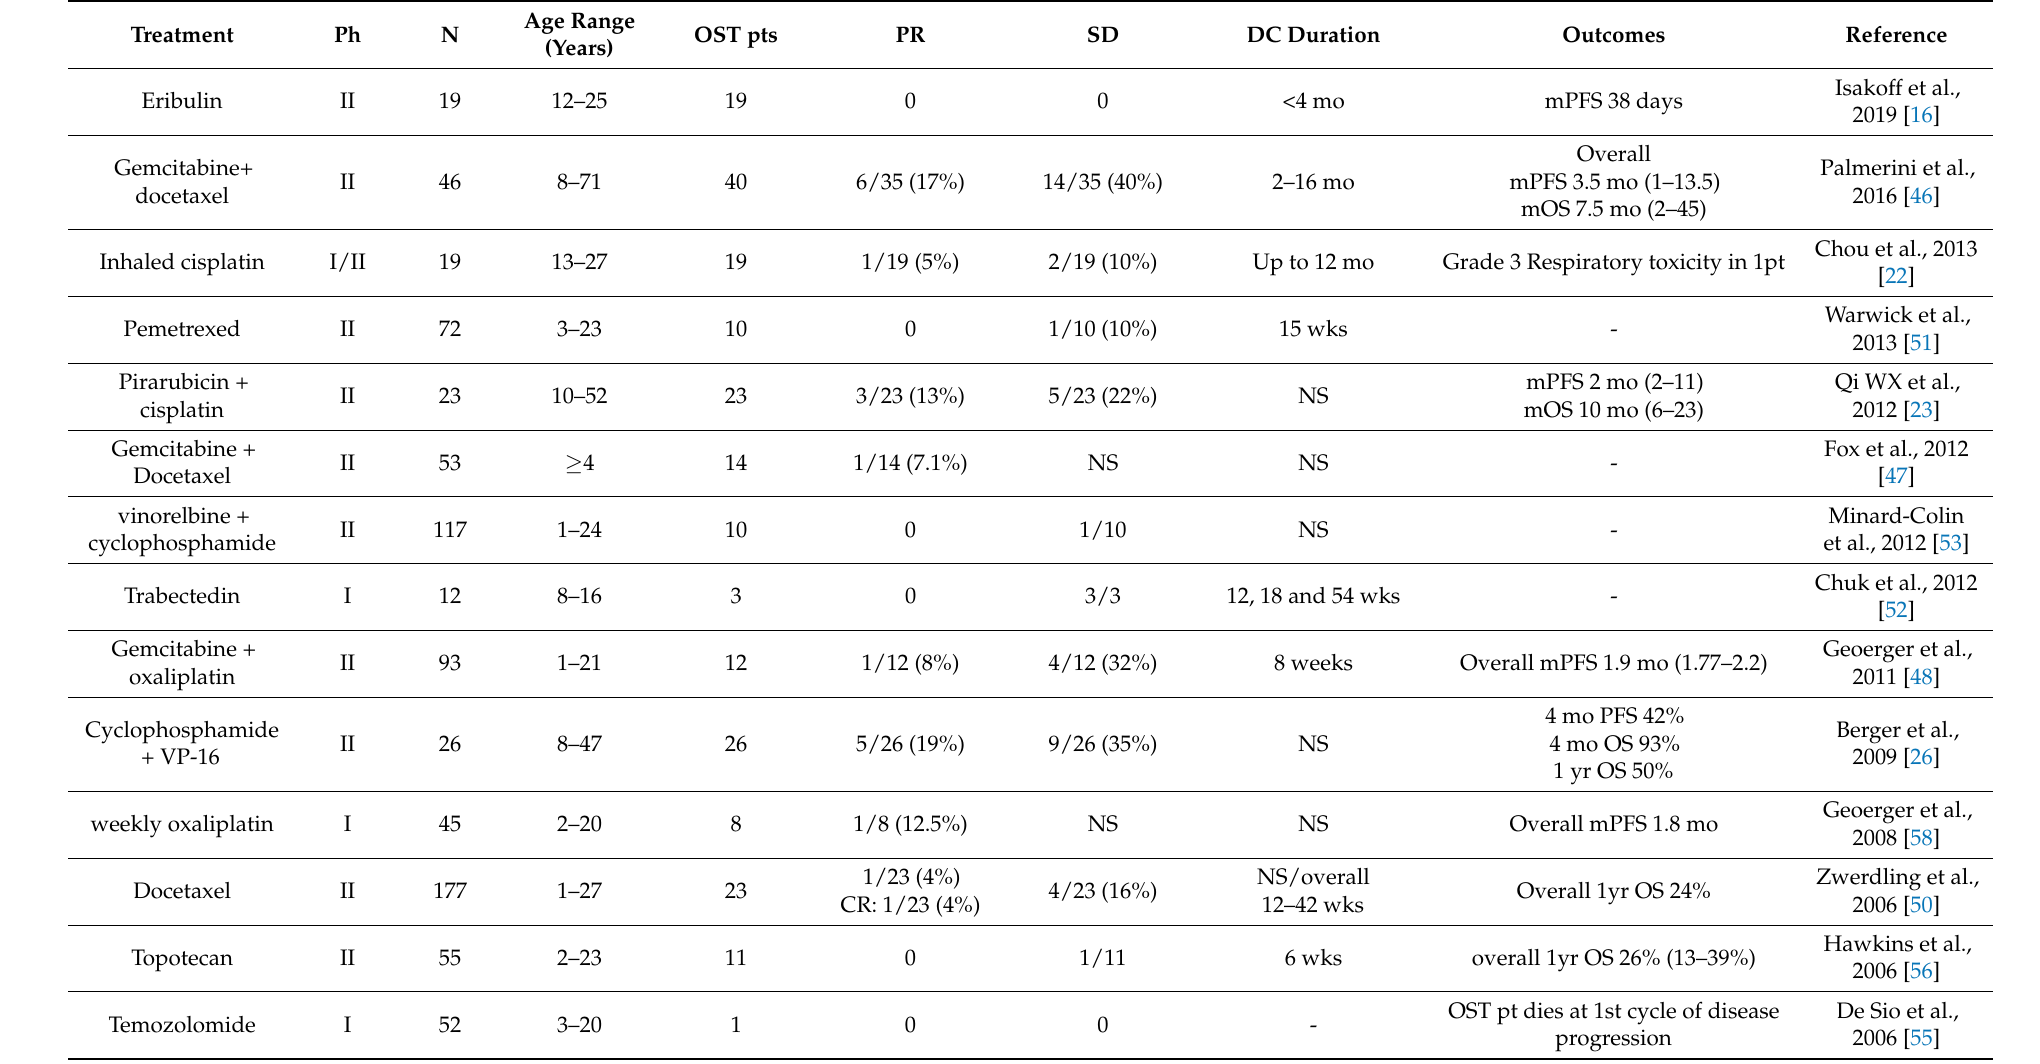
Table 1. Chemotherapeutic agents (19